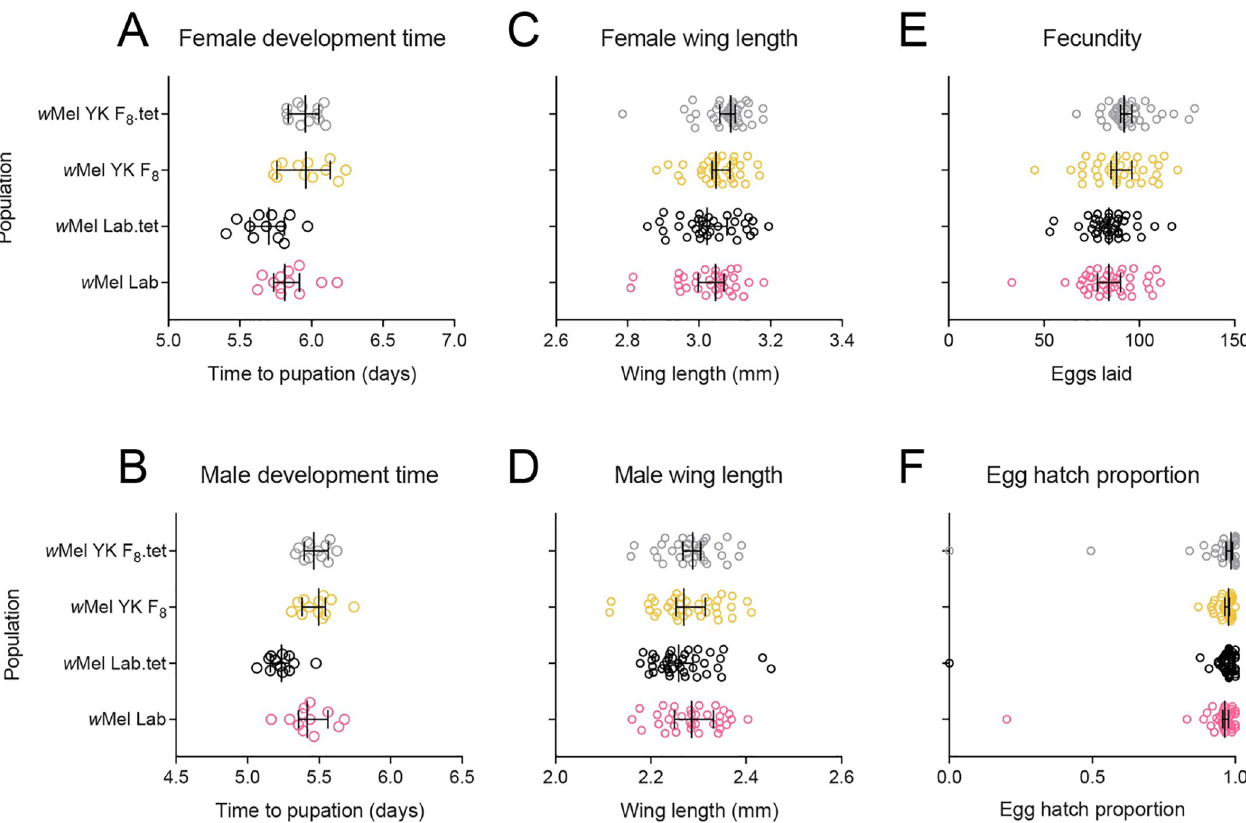
Fig 2. Phenotypic effects of w Mel in laboratory and field Aedes aegypti backgrounds. w Mel-infected populations were compared to tetracycline-cured counterparts to control for genetic background between infected and uninfected mosquitoes. Populations were measured for (A) female and (B) male development time, (C) female and (D) male wing length, (E) fecundity and (F) egg hatch. Data from two replicate populations were pooled for visualization. Dots represent data from replicate trays (A-B) or individual mosquitoes (C-F). Vertical lines and error bars represent medians and 95% confidence intervals.